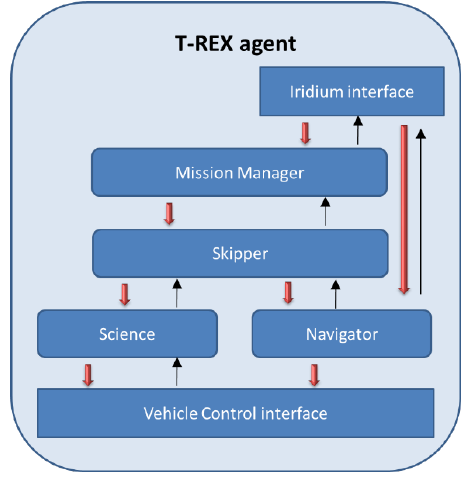
Figure 13. T-REX architecture, as described in [53].